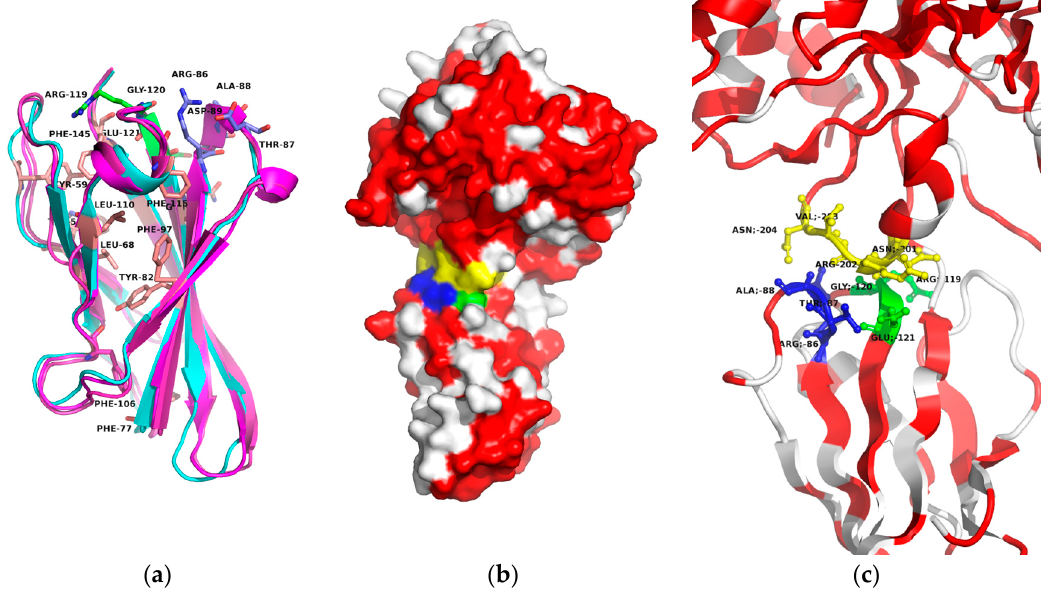
Figure 6 . ( a ) Ribbon diagram of the superimposed Fn3 domain structures from Ba0330, Bc0361 (in shades of purple) and Ba0331 (in cyan) with the totally conserved hydrophobic residues in pink and the conserved interacting loops RTAD (res. 86–89 in blue) and RGE (res. 119–121 in green). ( b ) The Fn3 surface association with the NodB domain. ( c ) The Fn3-NodB contact in ribbon representation with amino acid residue details. Conserved loop RGE between Fn3 β 5– β 6 β -strands in green and loop RTAD between β 3– β 4 strands in blue, NodB interacting loop in yellow (res. 201–204). Conserved surface residues between Ba0330 and Ba0331 are coloured in red. Diagrams created using the program PyMOL.